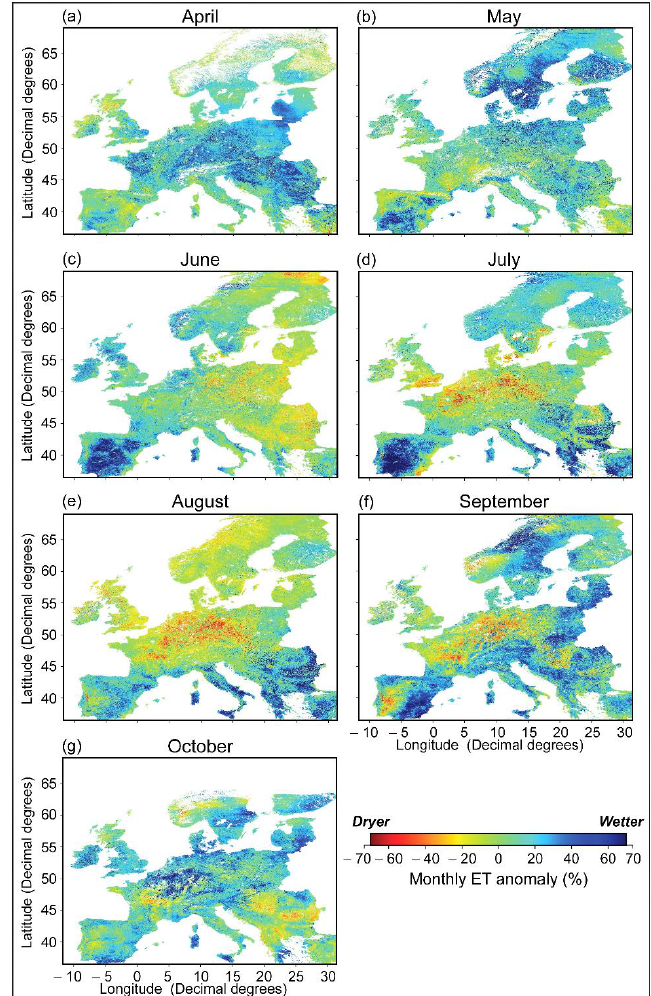
Figure 3. Evapotranspiration (ET) anomalies. Individual ET anomaly maps, from ( a – g ), show the normalized difference in percent between monthly mean ET for April to October 2018 (drought) compared to the reference monthly ET for April to October averaged between 2007 and 2017 (no drought). The maps are calculated from the MODerate Resolution Imaging Spectroradiometer (MODIS) MOD16A2 version 6 Total ET product. White-colored areas are either no-data or non- vegetation pixels.